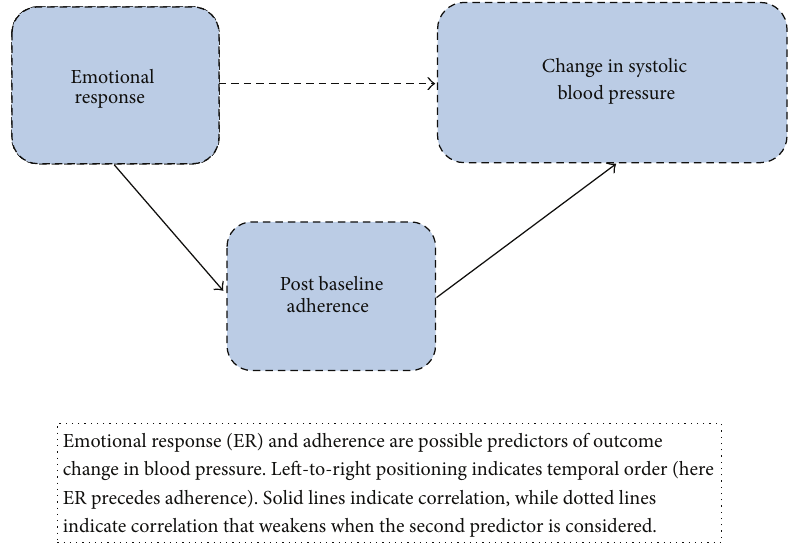
Figure 2: Mediator